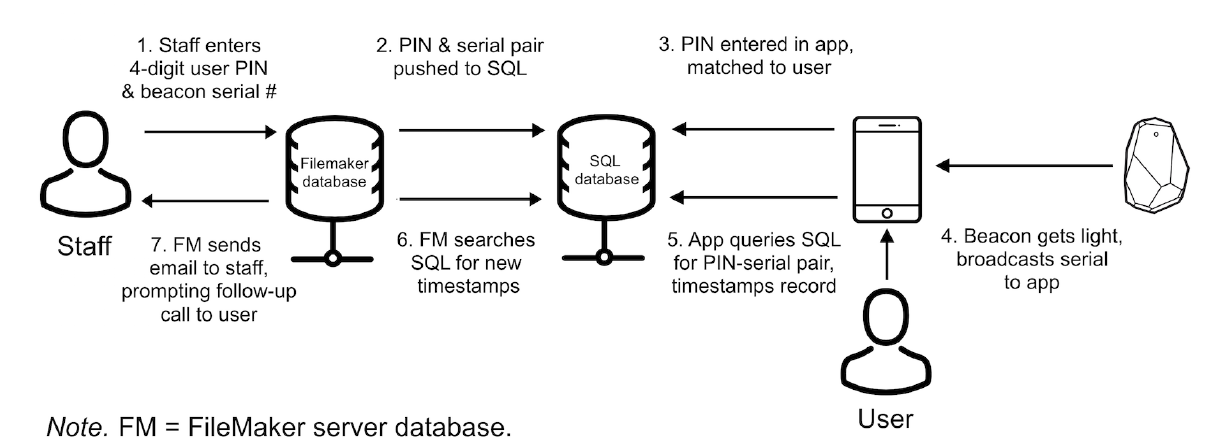
Figure 1. Flow of eTEST system